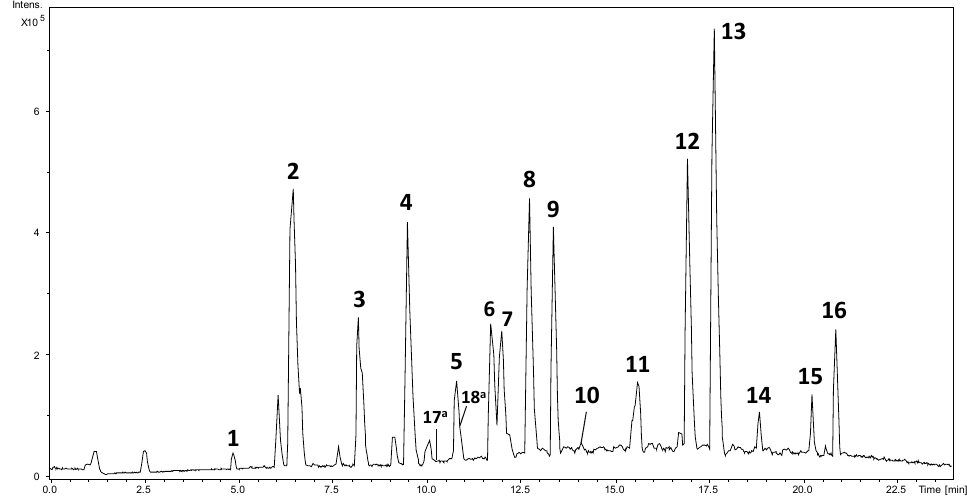
Figure 6. Total Ion Chromatogram (TIC) of Ro obtained by LC-ESI-MS/MS analysis (negative mode). a Annotations from LC-ESI-MS/MS analysis in positive mode.